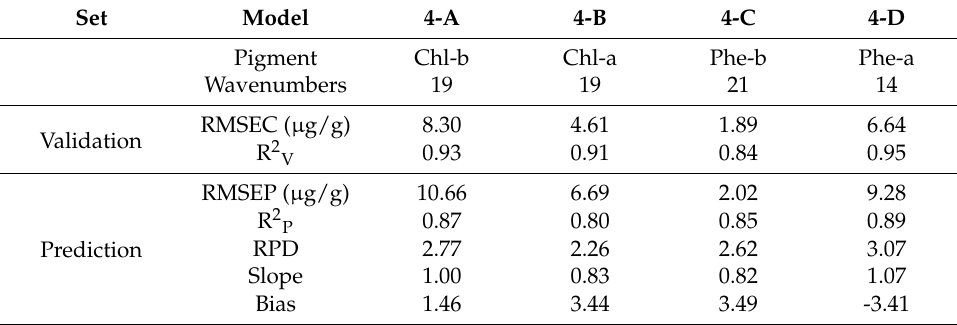
Table 5. The LS-SVM model results based on the characteristic